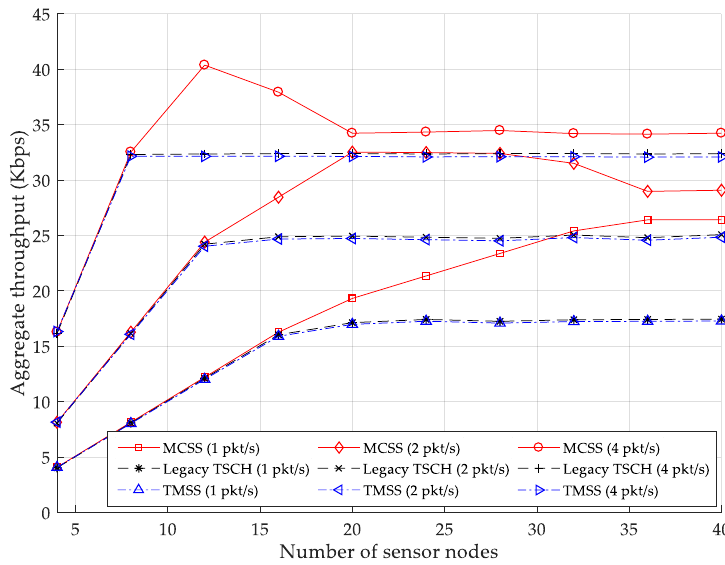
Figure 9. Aggregate throughput.